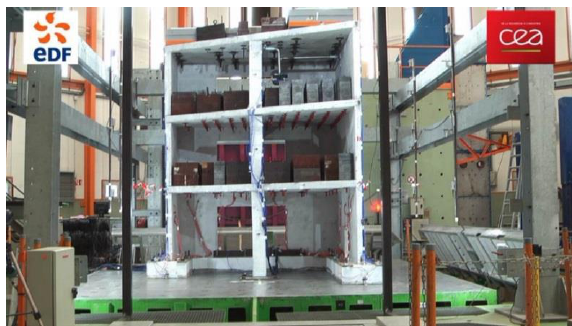
Figure 1. The asymmetric three-storey reinforced concrete building used for the SMART (Seismic design and best-estimate Methods Assessment for Reinforced concrete buildings subjected to Torsion and nonlinear effects) 2013 international benchmark campaign.